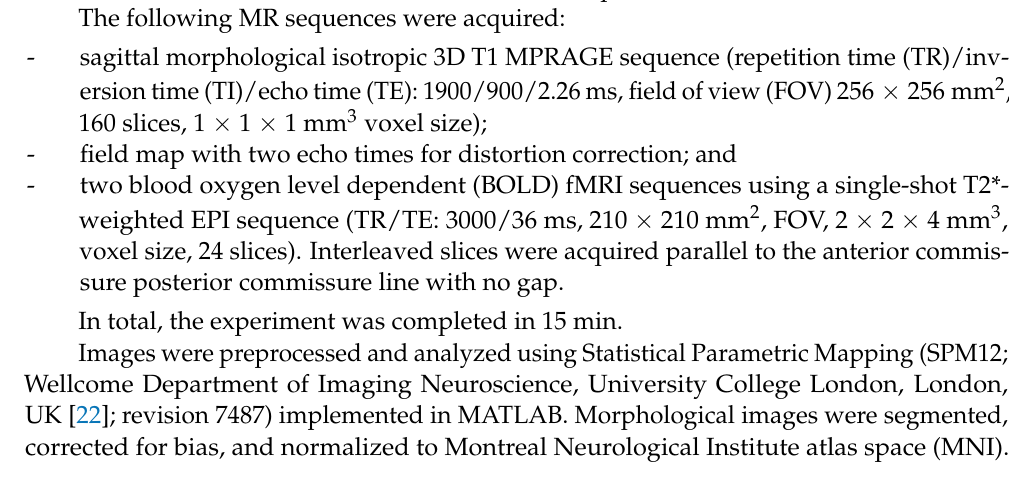
Figure 2. Schematic diagram of the subjective longitudinal body fMRI task. The dotted arrow represents the bar’s motion. The empty bars represent the virtual continuous plane centered on the navel.